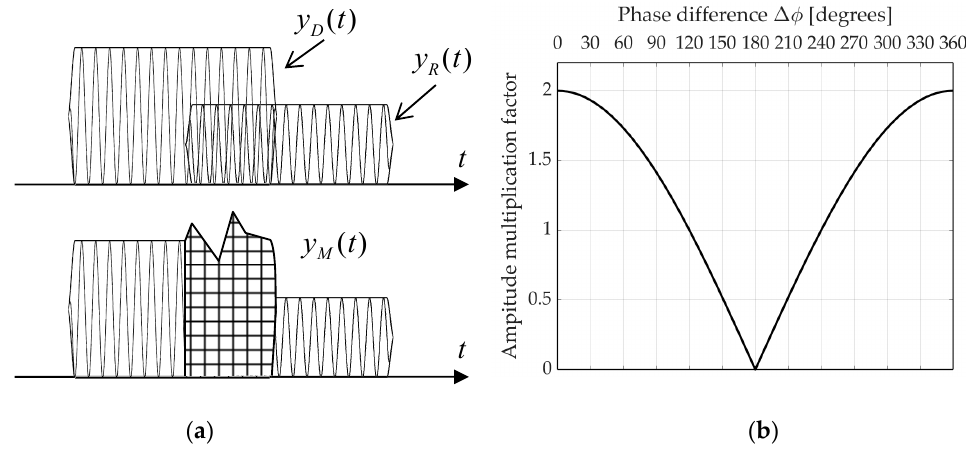
Figure 4. ( a ) Diagram showing how the multipath affects the pulse envelope ; ( b ) amplitude multiplication factor for the combination of two equal amplitude signals [1]. The graph relates to the result of two constant-frequency pulses combined. In the case of chirped pulses, a multipath will cause abrupt variations in the amplitude profile during the time.